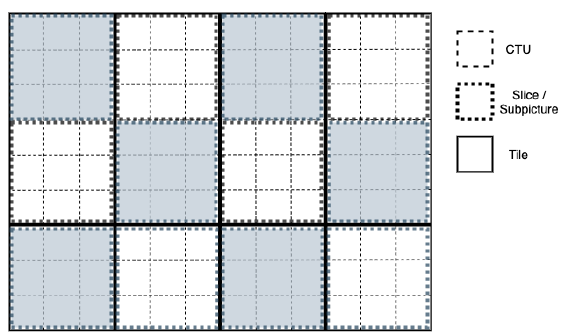
Figure 3. Example of subpicture partitioning (4 × 2 tiles, 12